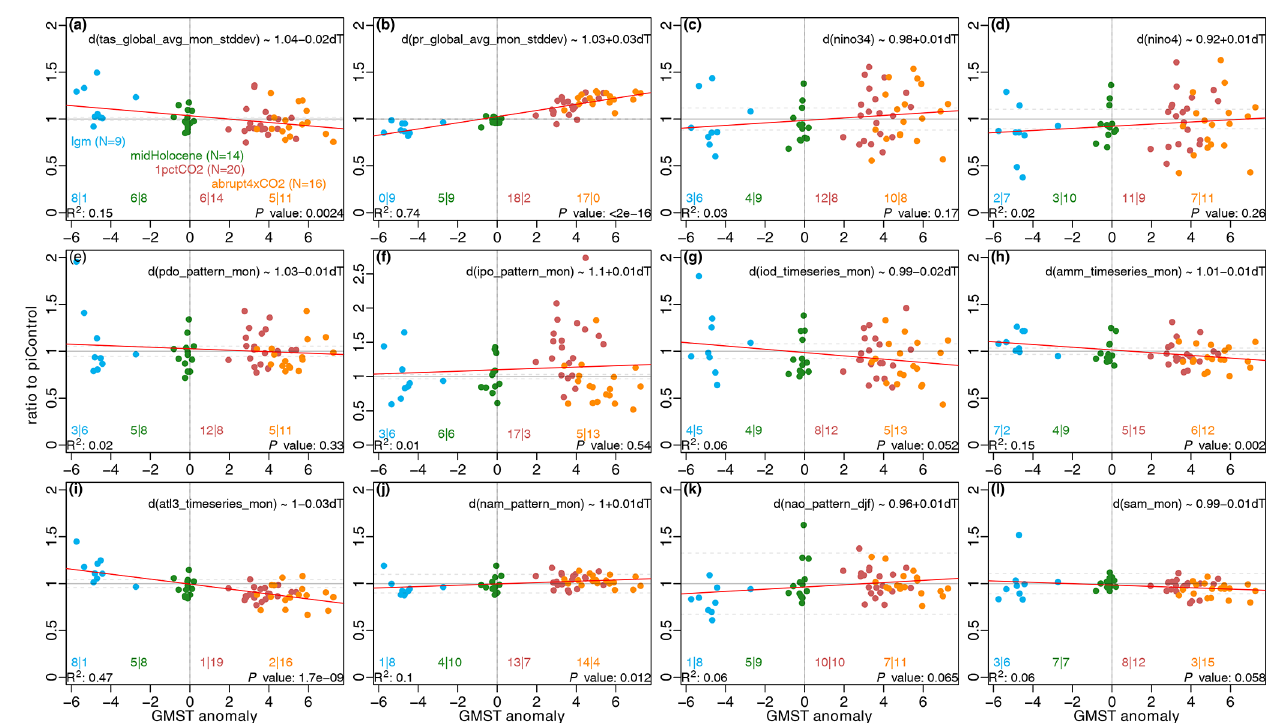
Figure 4. Relationship of the standard deviation of climate indices and modes to the change in global mean temperature from preindustrial conditions. Colors indicate the different experiments: CMIP5 and CMIP6 models are not differentiated. (a) Change in the standard deviation of the global annual mean surface temperature. (b) Change in the standard deviation of the global annual mean precipitation rate. Changes in the standard deviation (i.e., amplitude of the mode) of (c) ENSO based on the Niño3.4 index and (d) based on the Niño4 region, (e) the PDO, (f) the IPO, (g) the IOD, the meridional ( h , AMM) and zonal ( i , ATL3) modes of equatorial Atlantic SST variability, (j) the Northern Annular Mode, (k) the boreal winter NAO, and (l) the Southern Annular Mode. Dashed horizontal lines are given from 1 ± 2 σ int , mode . See Sect. 2.7 for details on the individual modes and how changes in the mean state between the experiments are removed prior to calculation. Linear unweighted fits to the mode changes are given in each panel without censoring for significance. P values assume 60 degrees of